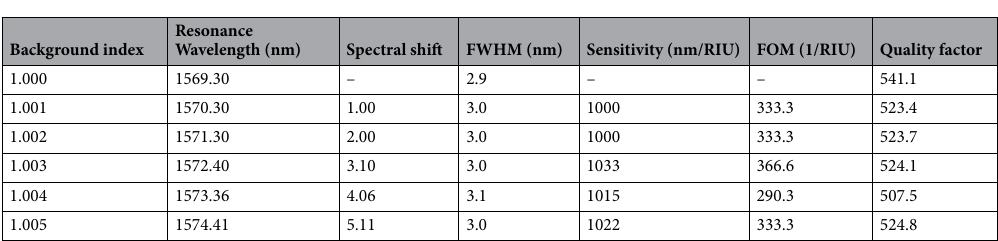
Table 2. The characteristics of resonance peaks under the variation of background